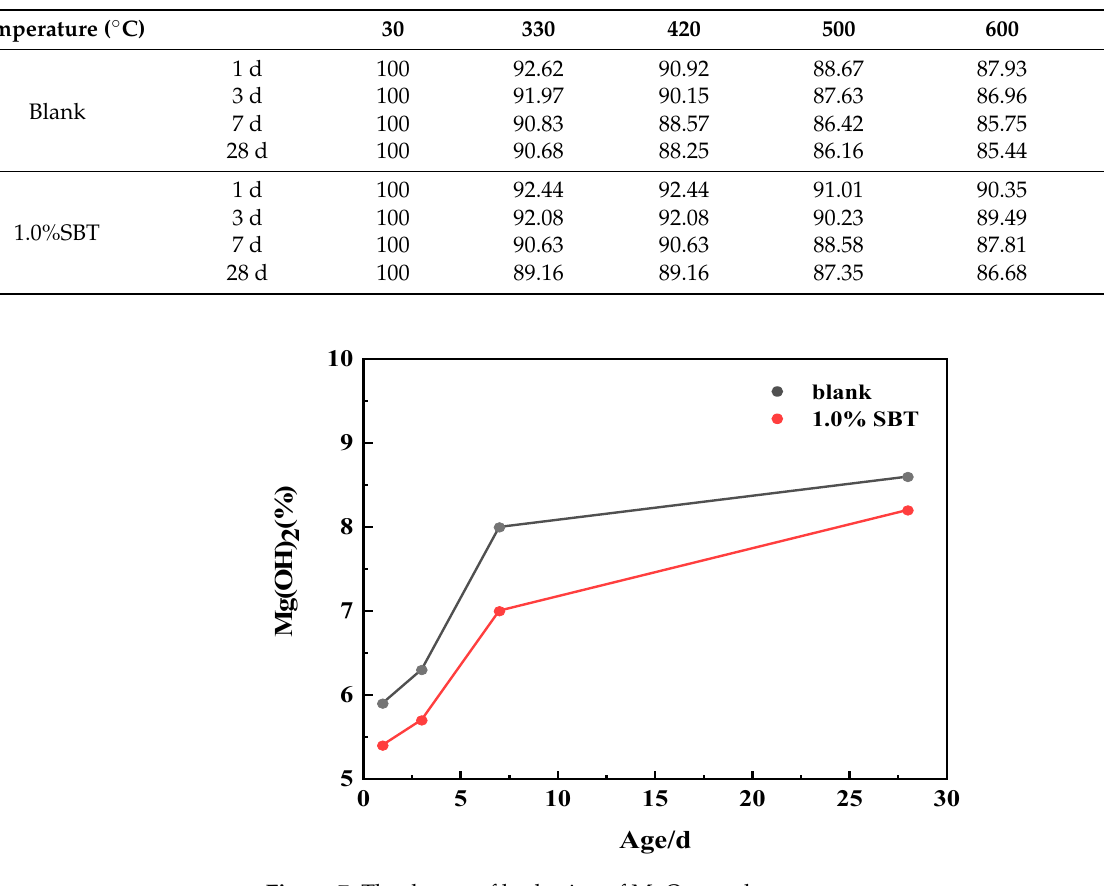
Figure 7. The degree of hydration of MgO at each age.